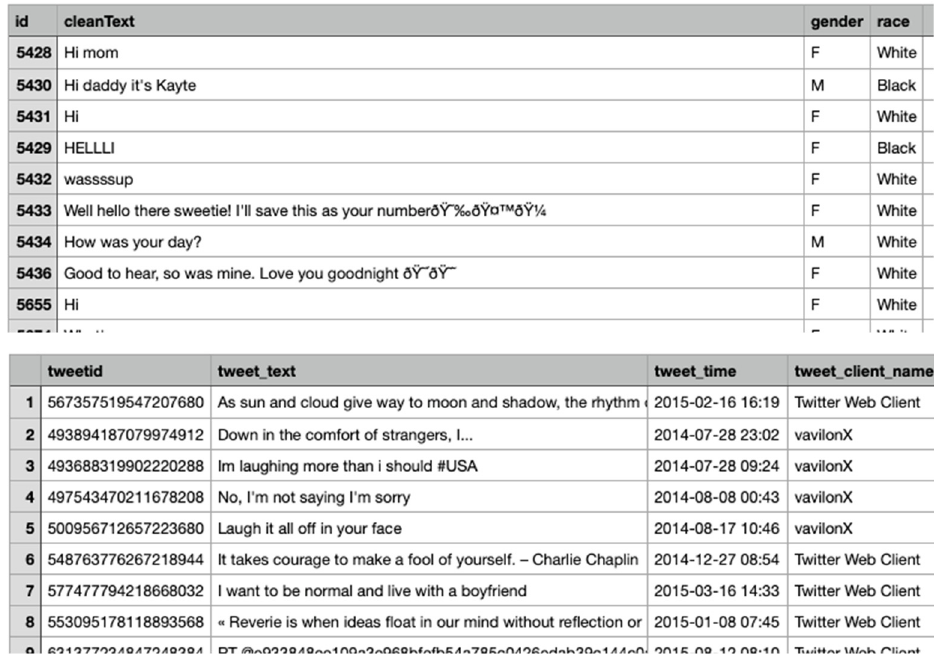
Figure 3. Input files (in Excel), which allows saving in CSV format.